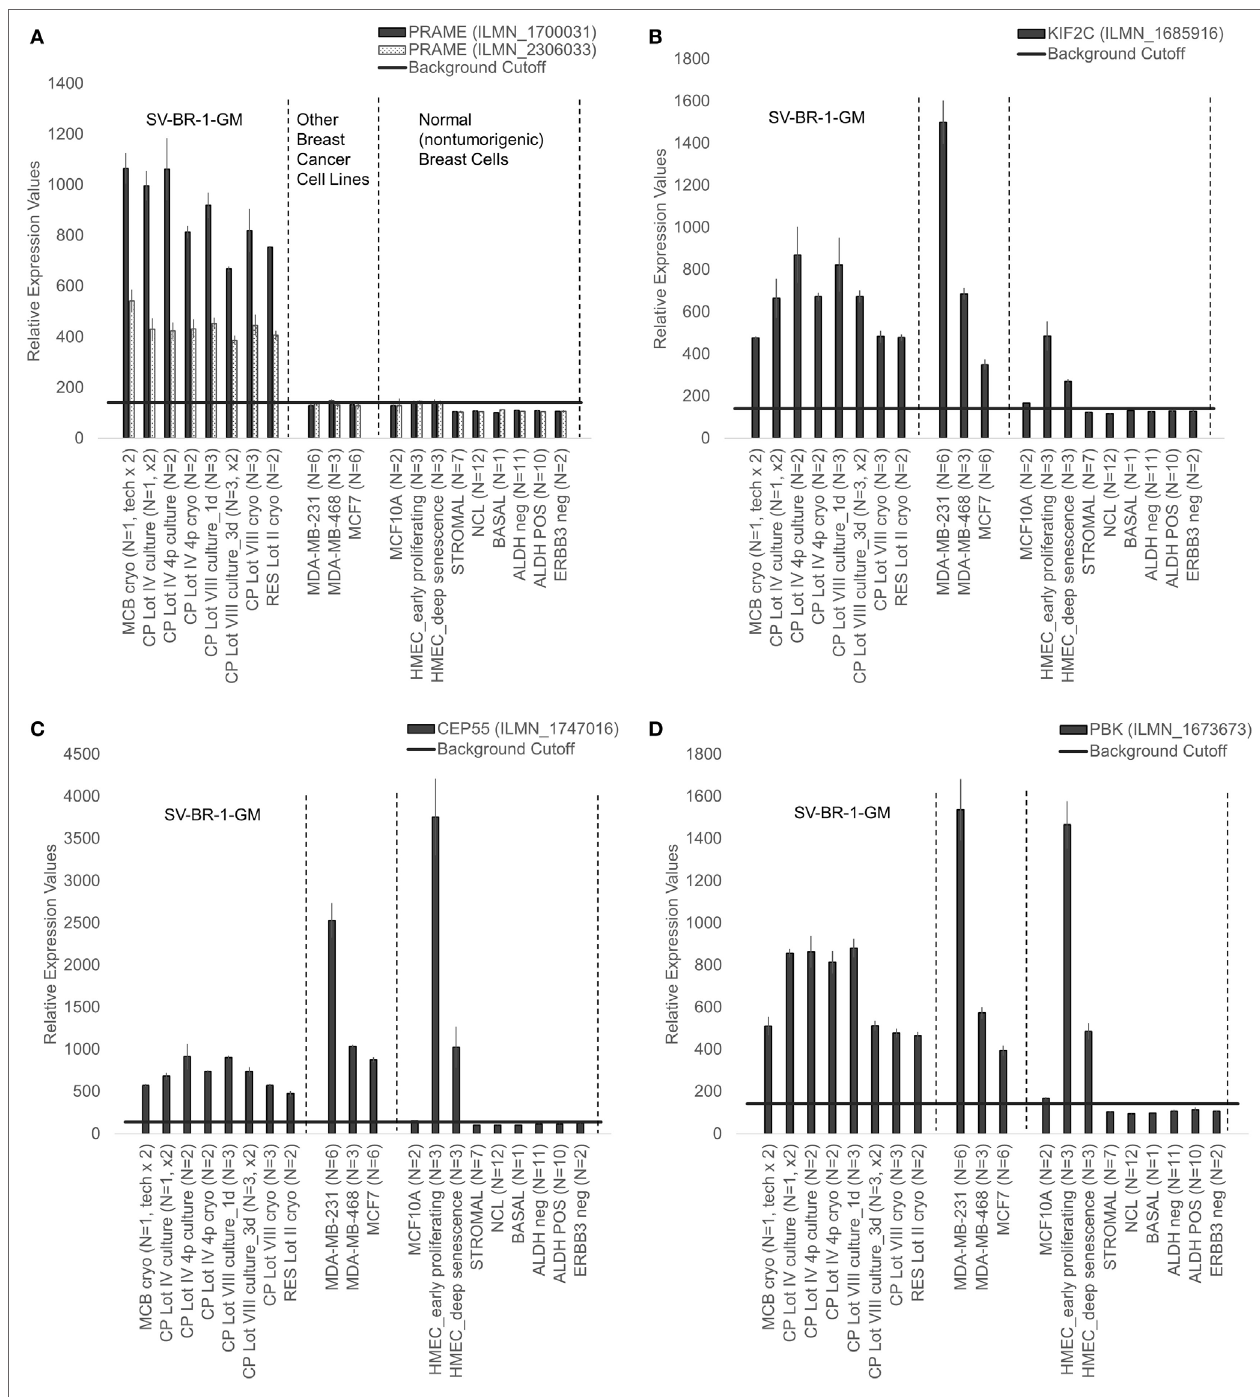
FigUre 8 | Cancer/testis antigen selectively expressed in SV-BR-1-GM cells. Quantile-normalized microarray-based RNA levels of PRAME (a) , KIF2C (B) , CEP55 (c) , and PBK (D) “Relative Expression Values” refers to quantile-normalized mRNA levels. Values shown are arithmetic means. Error bars indicate SDs, except